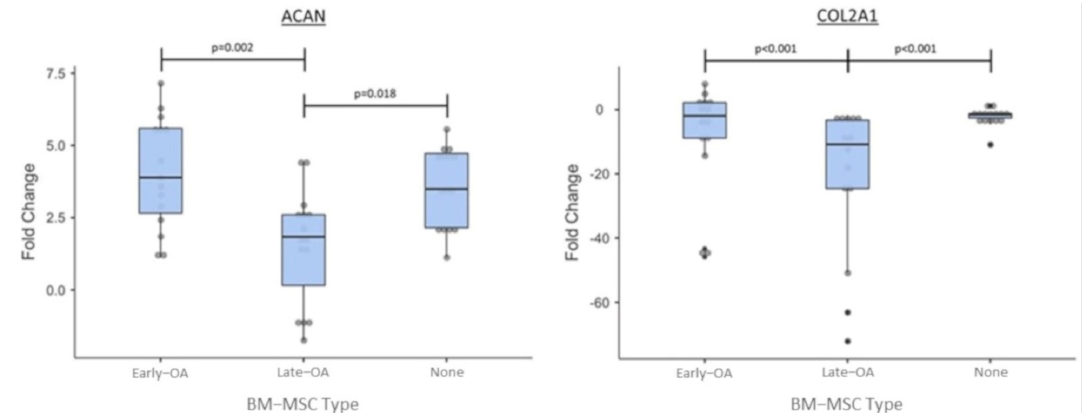
Figure 11. Relative fold change of ACAN and COL2A1 between day 0 and day 21 of the co-culture. Error bars represent the standard error of the mean. Significant differences are indicated by horizontal